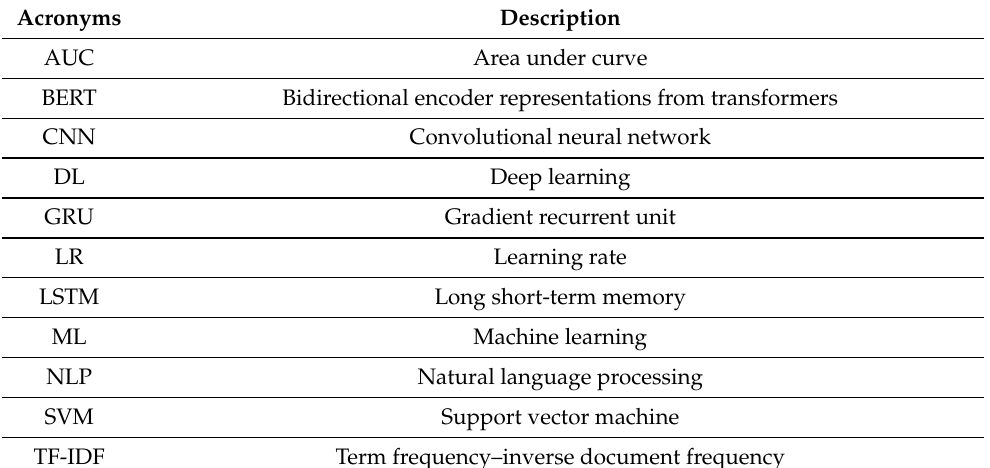
Table 1. Different acronyms used in this